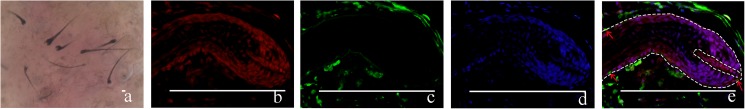
Hair reconstruction of the cell spheroids inside the capsules 10 d after the transplantation.(a) Cell spheres inside the capsules were acquired for single transplantation into nude mice. Thirty days after transplantation, mature hair follicles were reconstructed successfully. (b) Red fluorescence of the reconstructed hair follicle. (c) Green fluorescence figure of the reconstructed hair follicle. (d) DAPI staining of the reconstructed hair follicle. (e) Synthesis, arrows indicate GFP cells from host mice (red). Scale bars = 50 μm in a; and 100 μm in b, c, d, and e.